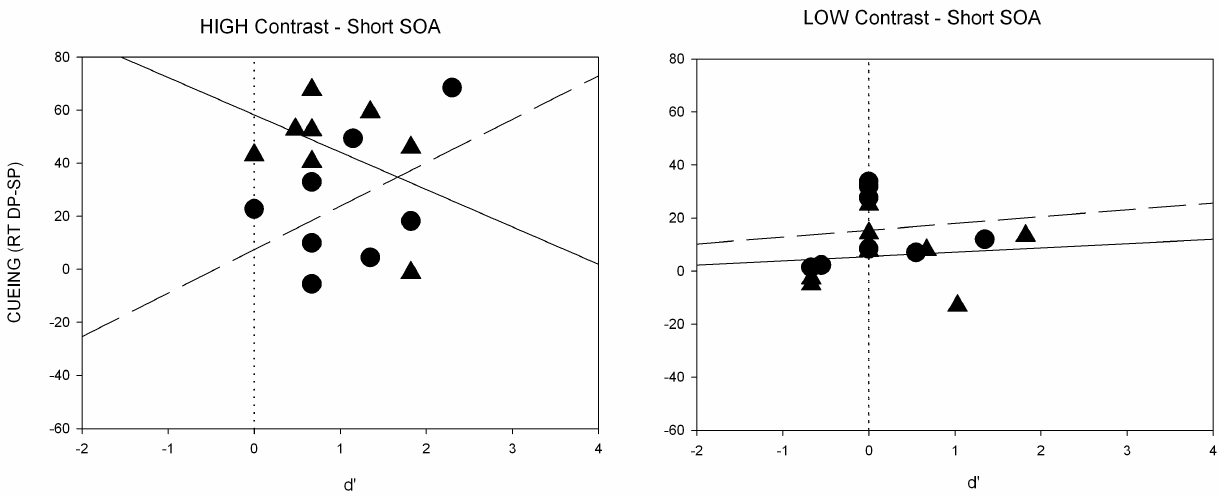
Figure A2. Individual scatter plots of the short SOA for Experiment 2. Shown are RT differences (cueing effects, i.e. , mean RTs for DP minus RTs for SP condition on the y -axis) and the respective d’ -value (on the x -axis) for each participant separately. Panels depict results for high-contrast (left side) and low-contrast cues (right side), separately. In each panel values are displayed for cues with the same polarity as the target (triangles; solid regression line) and with opposite polarity (circles; dashed regression